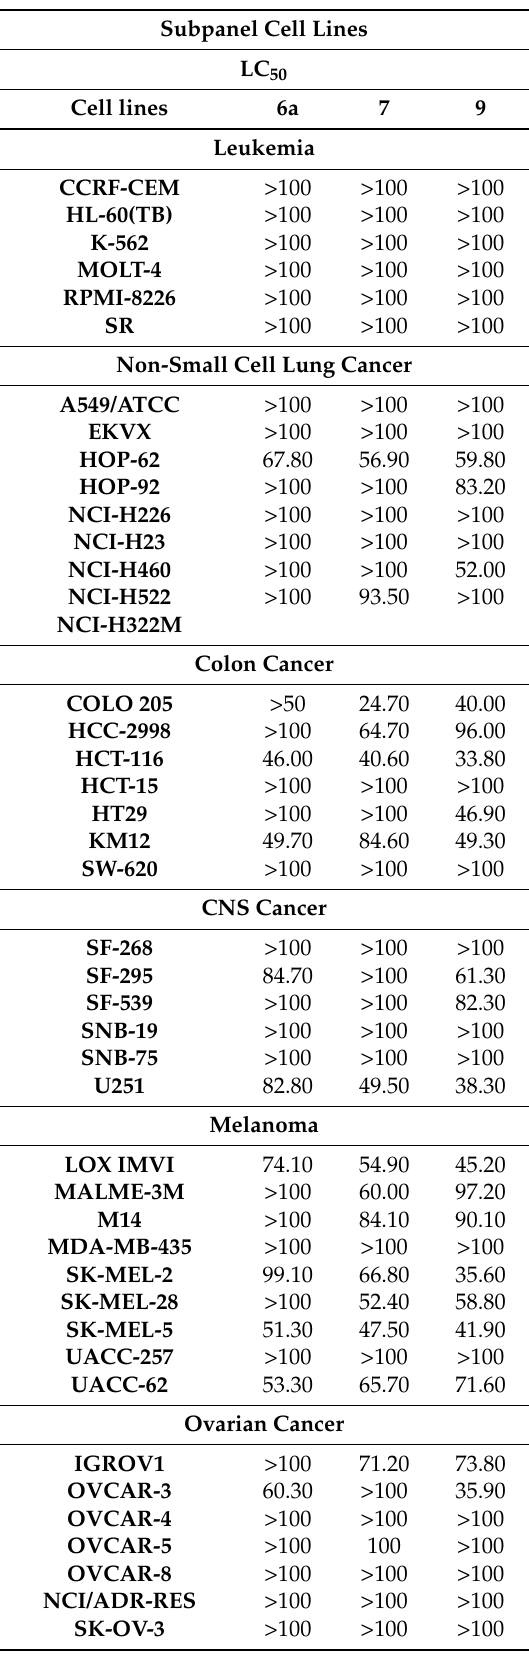
Table 4. LC 50 ( µ M) of five-dose screening results of compounds 6a , 7 and 9